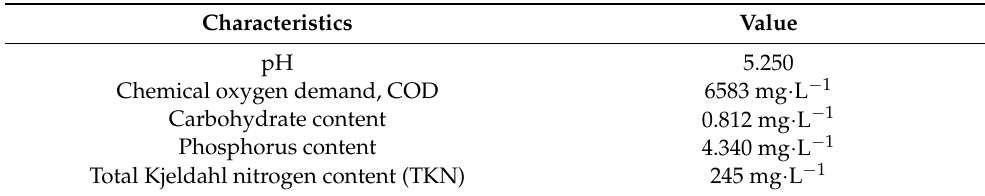
Table 1. Characteristics of raw leachate used in this